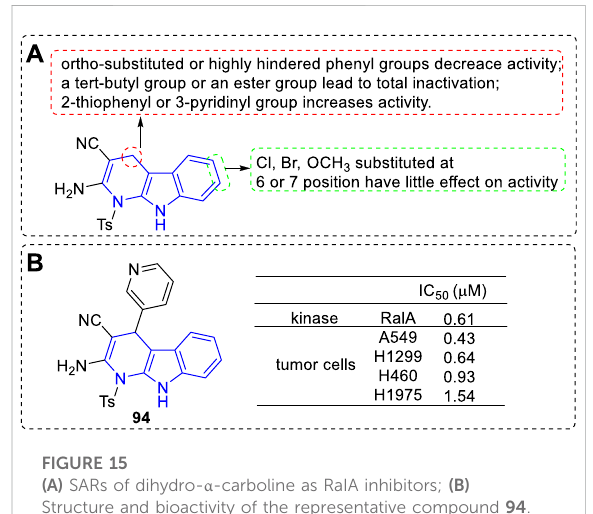
FIGURE 15 (A) SARs of dihydro- α -carboline as RaIA inhibitors; (B) Structure and bioactivity of the representative compound 94